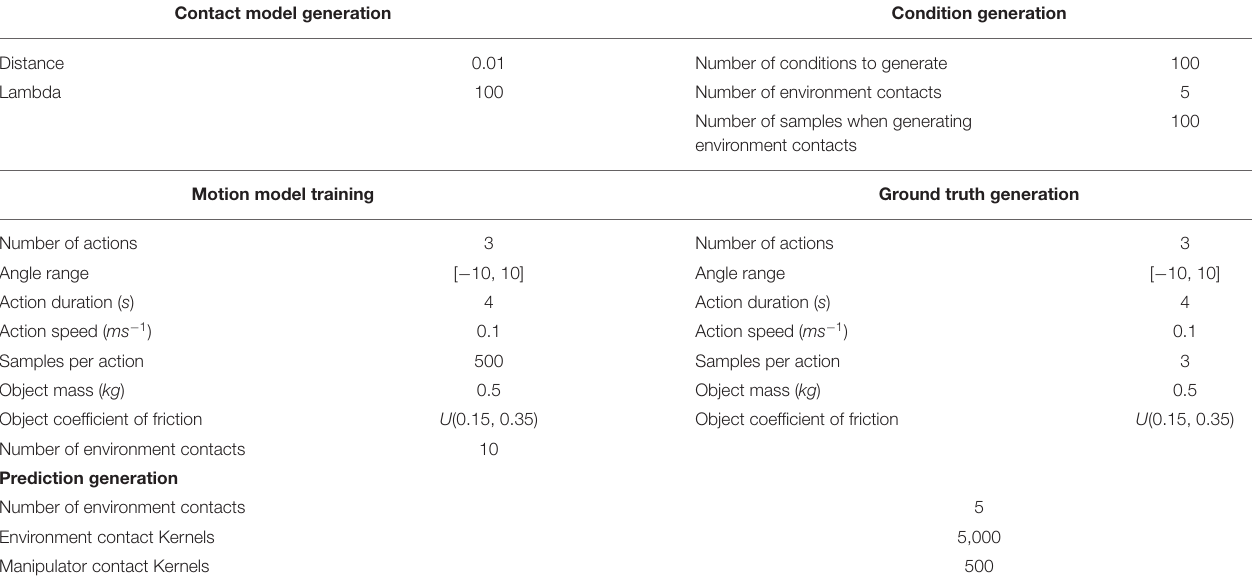
TABLE 2 | Experimental parameters for evaluating the selection of contact motion models (section